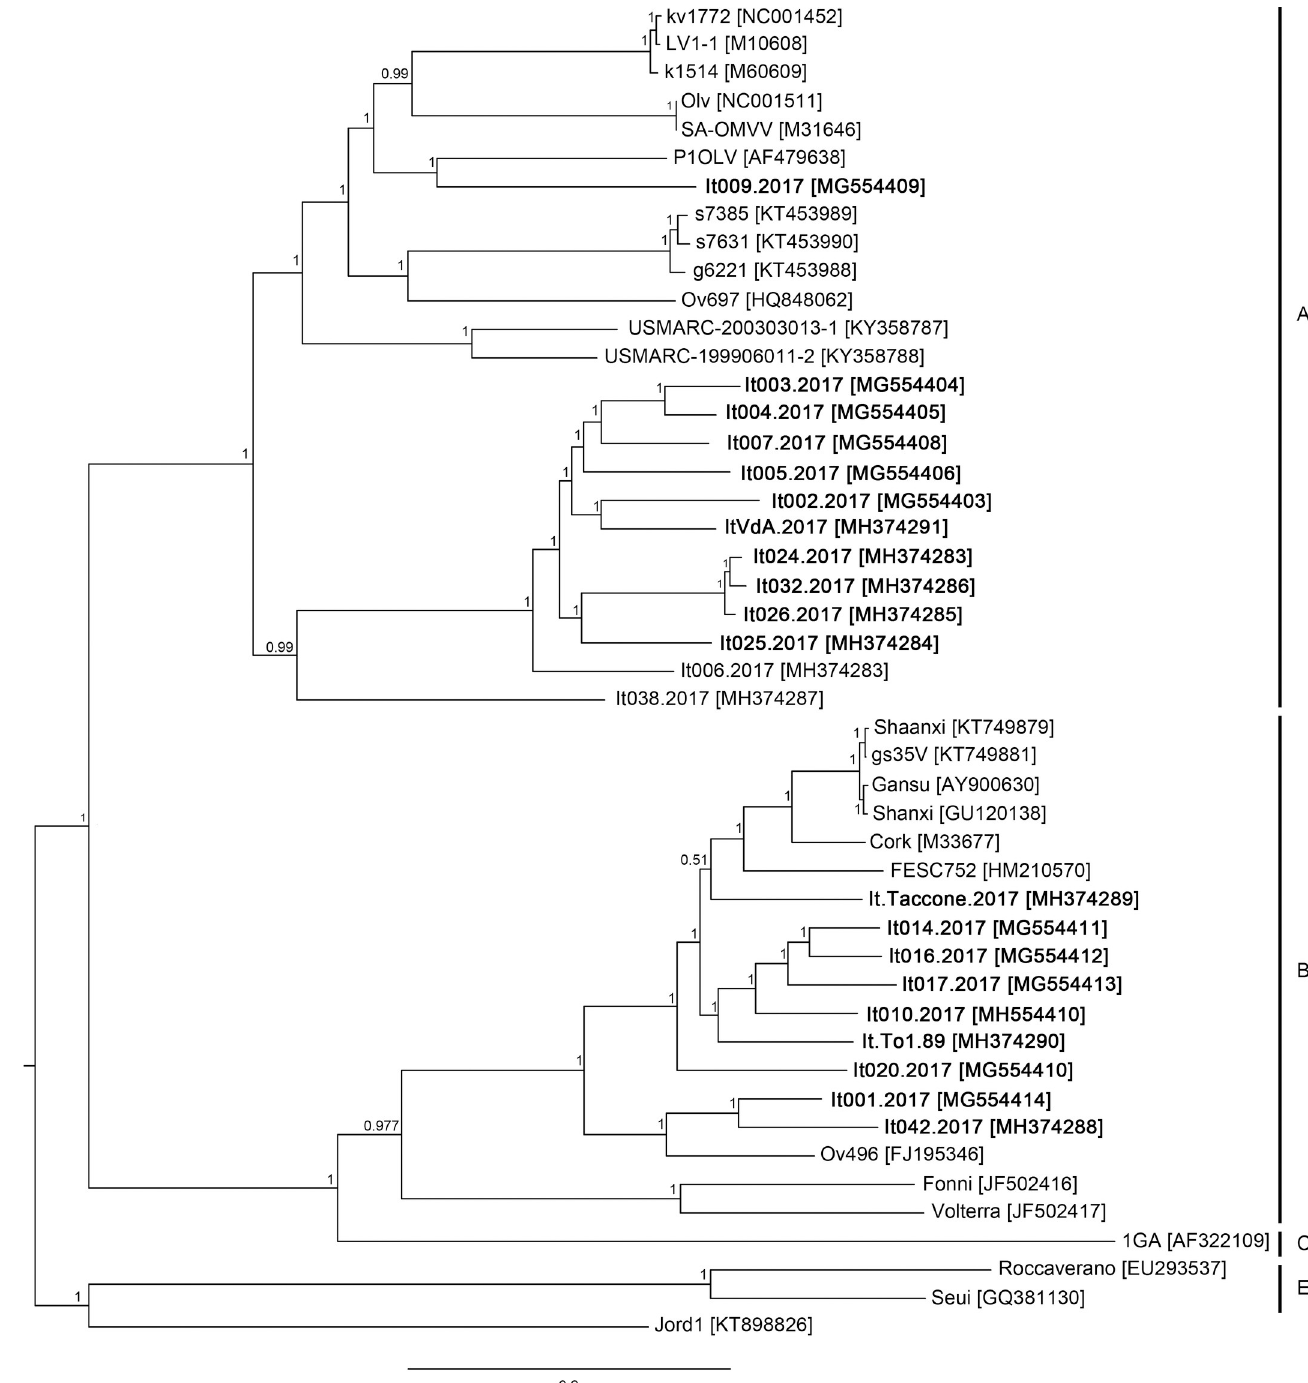
Fig 1. Bayesian tree based on the full genome sequences alignment. Newly characterized isolates are reported in bold. SRLV genotypes are reported. Posterior probability of each node is showed above branches.